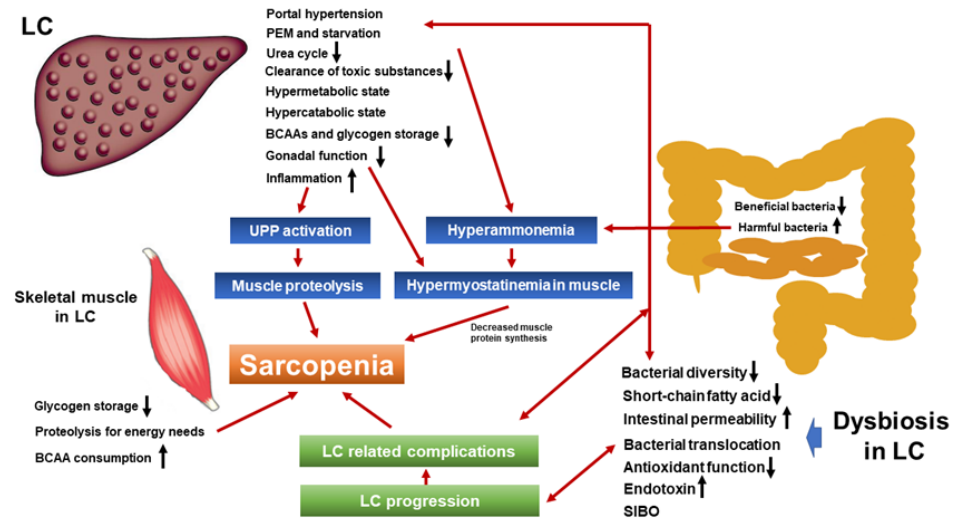
Figure 2. Schematic explanation of the relationship between sarcopenia and dysbiosis in patients with liver cirrhosis. LC: liver cirrhosis; PEM: protein-energy malnutrition; BCAA: branched-chain amino acid; UPP: ubiquitin-proteasome pathway; SIBO: small intestine bacterial overgrowth.